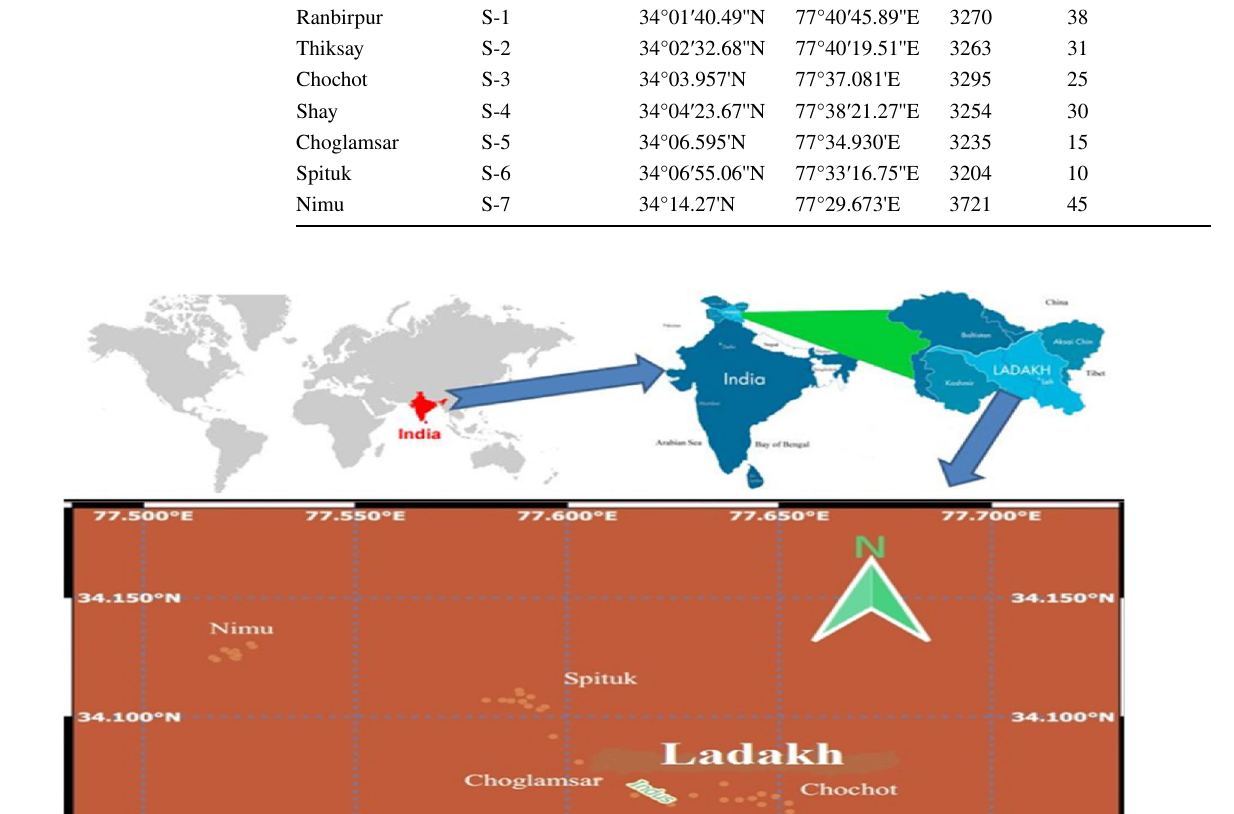
Table 1 Sampling location (seven different villages) of irrigation water from cold desert high-altitude microclimate